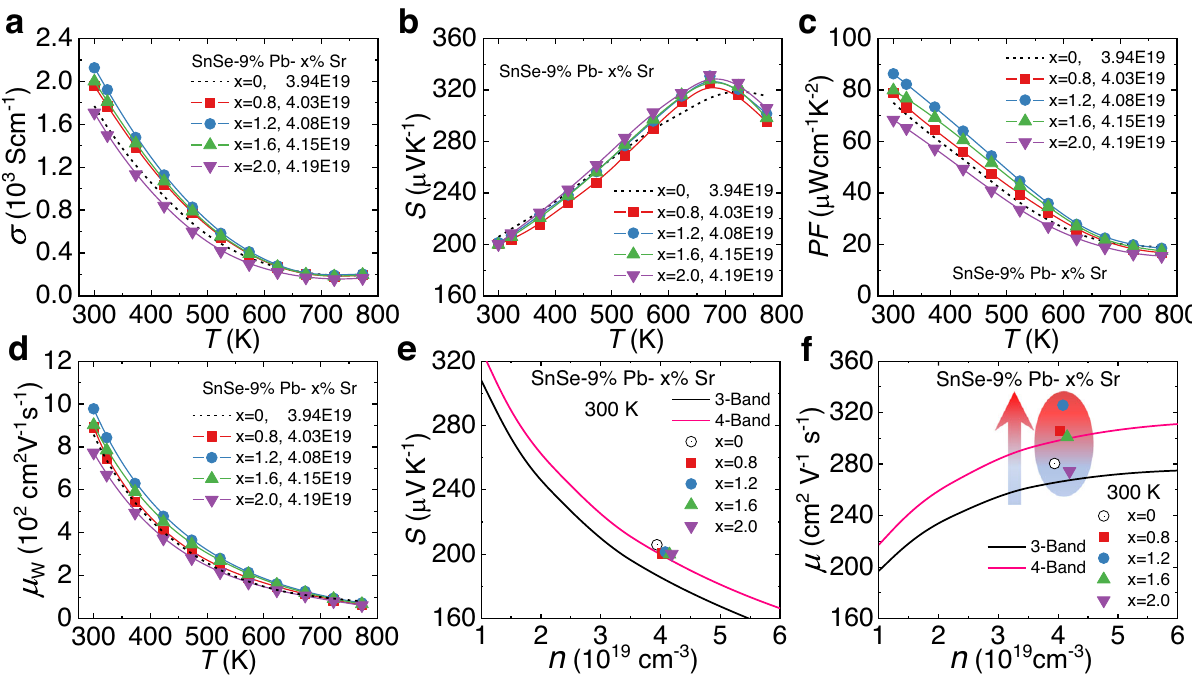
Fig. 2 | Temperature-dependent electrical performance for SnSe-9%Pb-x%Sr crystals.a Electricalconductivity σ . b Seebeckcoef fi cient S . c Powerfactor PF .and